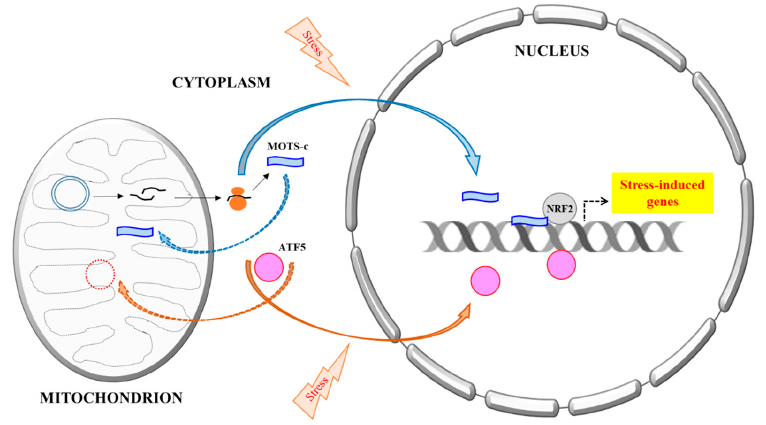
Figure 1. A schematic summary of the mitochondria DNA (mtDNA) encoded MOTS-c’s